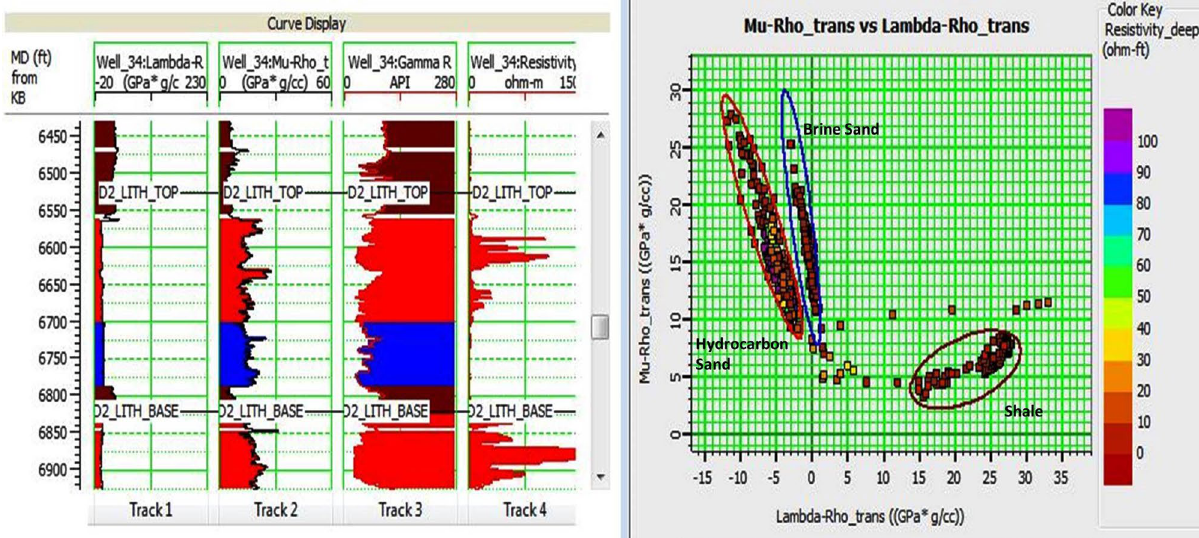
Fig. 6 Plot of Mu-Rho versus Lambda-Rho for C3 reservoir showing a good separation between sand and shale but a fair separation between brine and oil